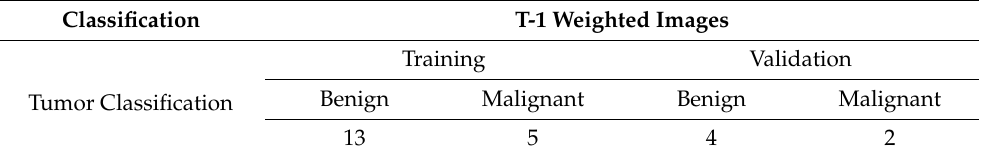
Table 3. T-1 weighted images for the